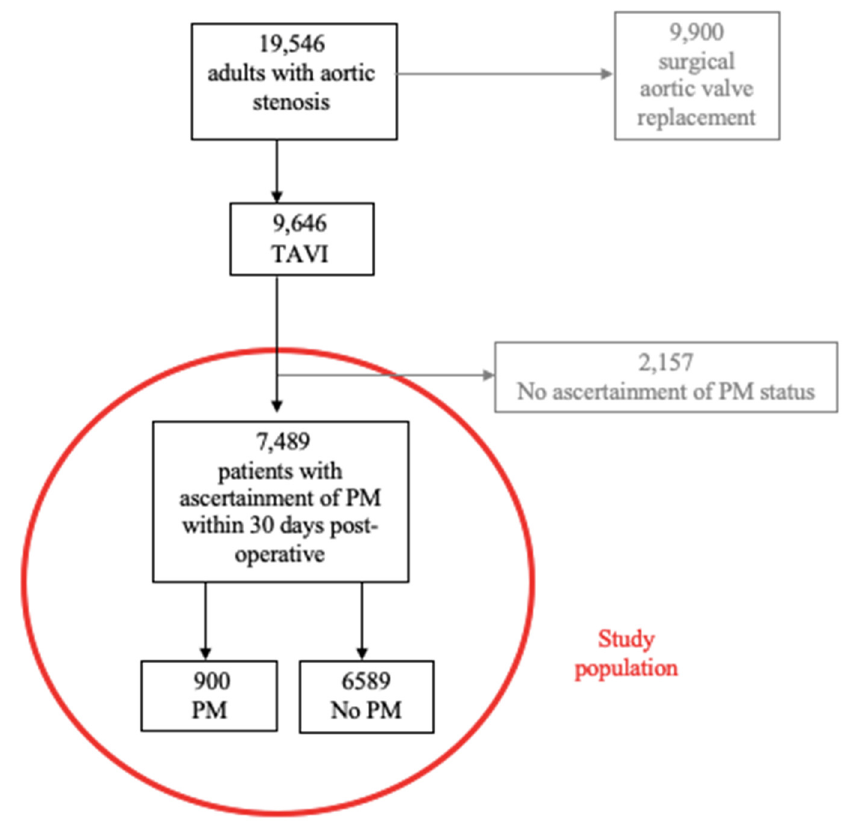
Figure 1. Flowchart of patients after transcatheter aortic valve implantation (TAVI) leading to permanent pacemaker (PM) implantation.